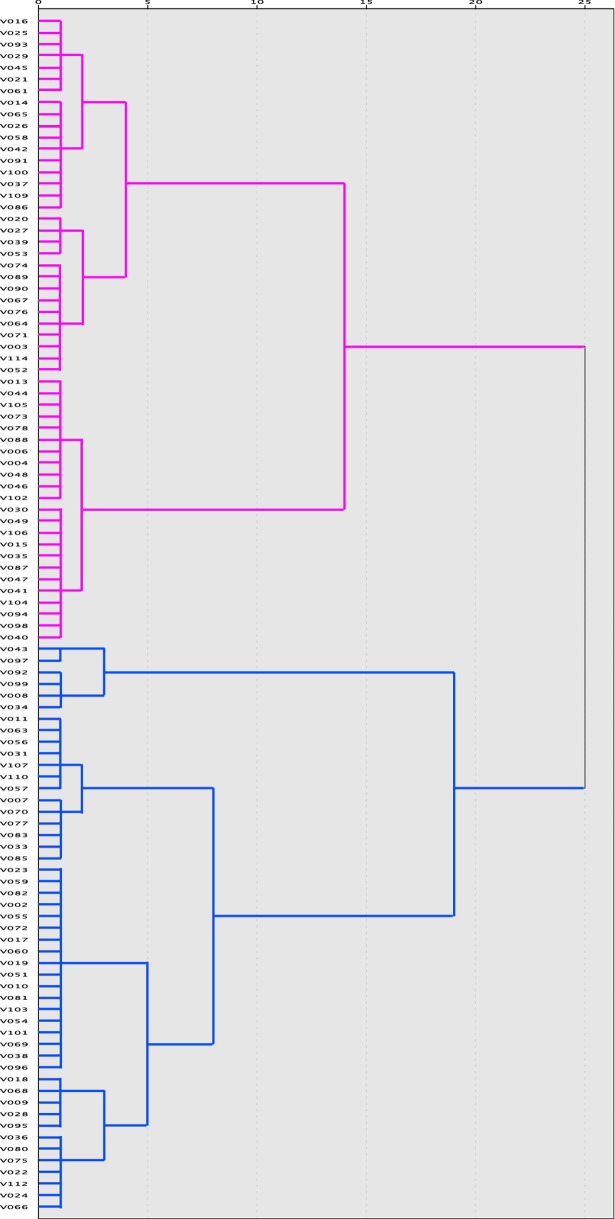
Dendrogram resulting from a hierarchical cluster analysis.Two clusters were observed: one with high levels of IPA (cyan color) and other with low levels of IPA (magenta color). After to remove participants with extreme values in age into each cluster, two homogeneous groups were obtained (Active Elderly: n = 48 and Passive Elderly: n = 49) for the further analyses.